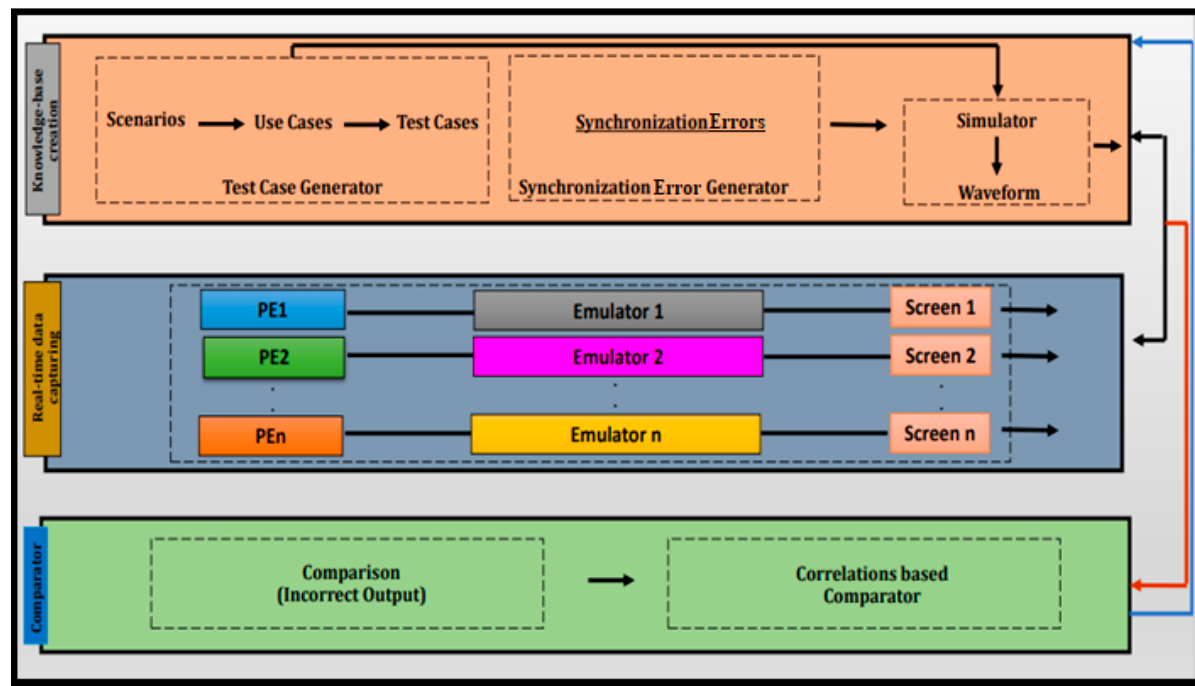
Figure 3. Creation of knowledge base technique.